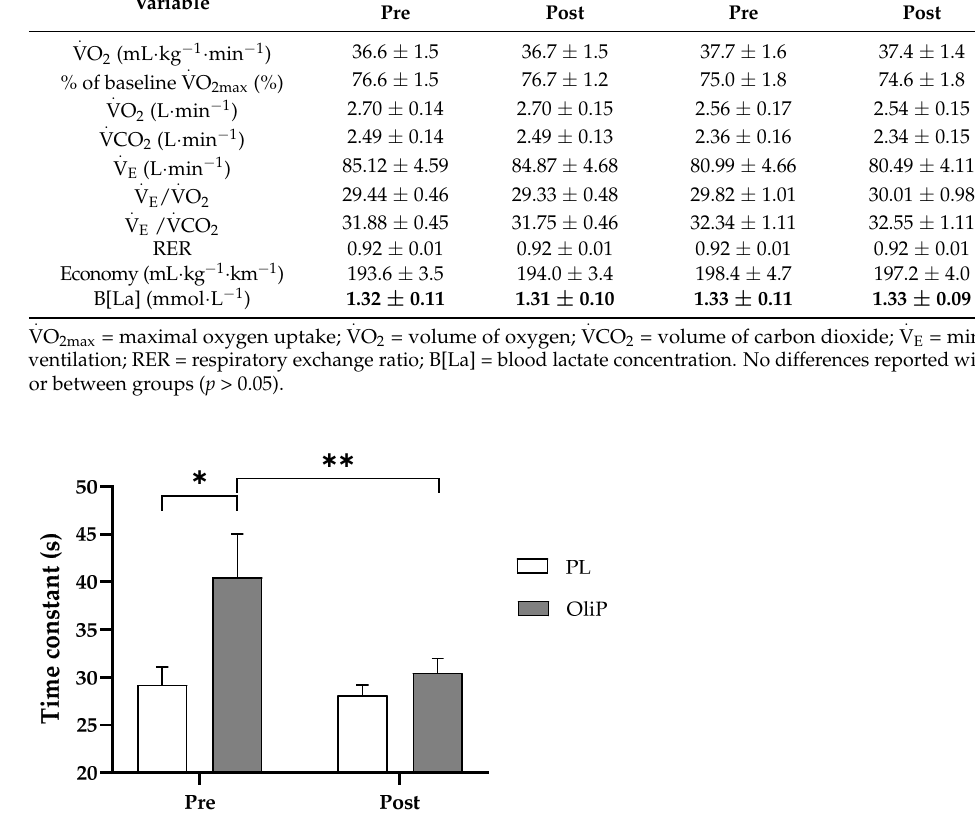
V̇ O 2 = volume of oxygen;